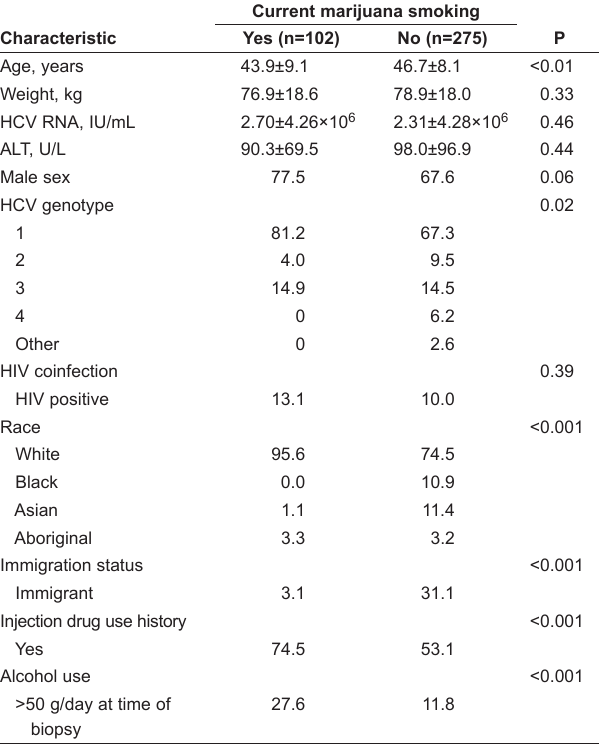
TAble 1 liver biopsy recipient characteristics as a function of marijuana smoking status at the time of biopsy